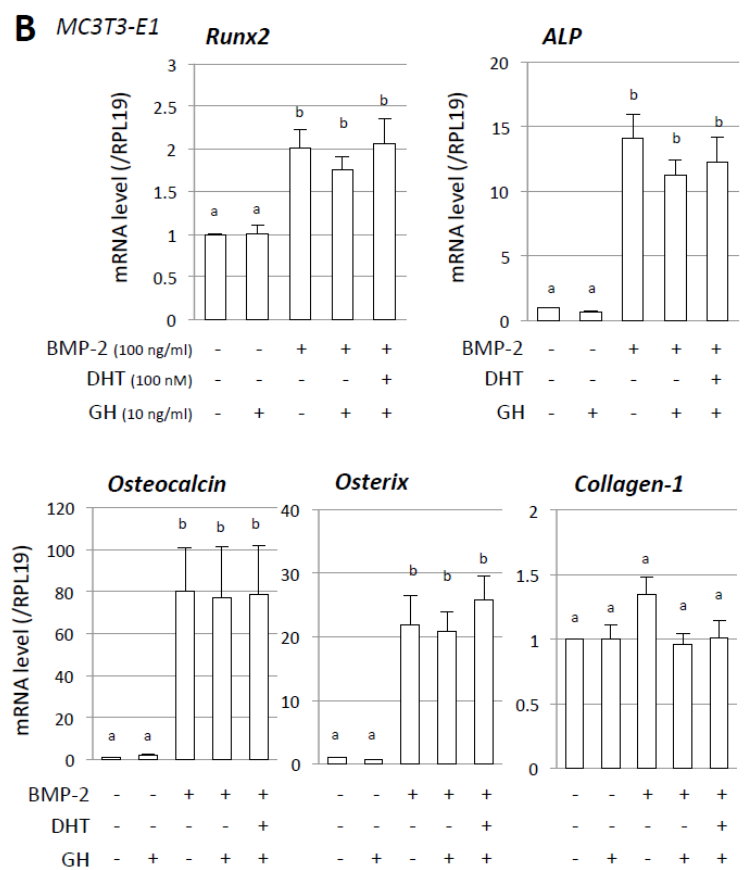
Figure 2. Combined effects of androgen and GH on BMP-induced osteoblast marker expression. ( A ) C2C12 and ( B ) MC3T3-E1 cells (2 × 10 5 cells/well) were treated with the indicated concentrations of DHT, GH, and BMP-2 in a serum-free medium. After 48-h culture, total cellular RNA was extracted and mRNA levels of Id-1 were examined by real-time RT-PCR. The expression levels of target genes were standardized by RPL19 mRNA levels in each sample. Results in all panels are shown as means ± SEM of data from at least three separate experiments, each performed with triplicate samples. The results were analyzed by ANOVA. For each result within a panel, the values with different superscript letters are significantly different at p <